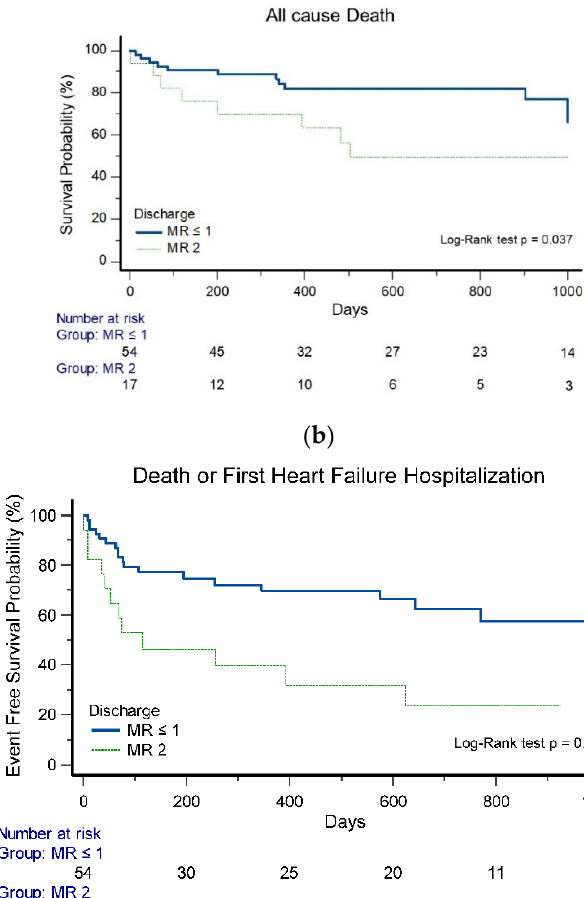
9 of 16 Figure 4. MVPG Correlation analysis at completion of TEEMr and at discharge. Scatter plots for Spearman’s correlation analysis between MVPG assessed by TEE at completion of TEEMr and MVPG assessed by TTE at discharge. Filled circles represent individual measurements. MVPG, Mi- tral valve pressure gradient; TEE, transesophageal echocardiography; TEEMr, Transcatheter edge- to-edge mitral valve repair; TTE, Transthoracic echocardiography. 3.6. Event Free Survival Analysis and Predictors of Outcomes Survival rates, by the Kaplan–Meier analysis, were higher in patients with rMR ≤ 2 at completion of TEEMr than those with rMR > 2 at completion of TEEMr (log-rank test, p = 0.008), (Figure 5a). There was no survival difference between patients with rMR ≤ 1 and pa- tients with rMR-2, at completion of TEEMr (Log-rank test, p = 0.238), nor in the time to the